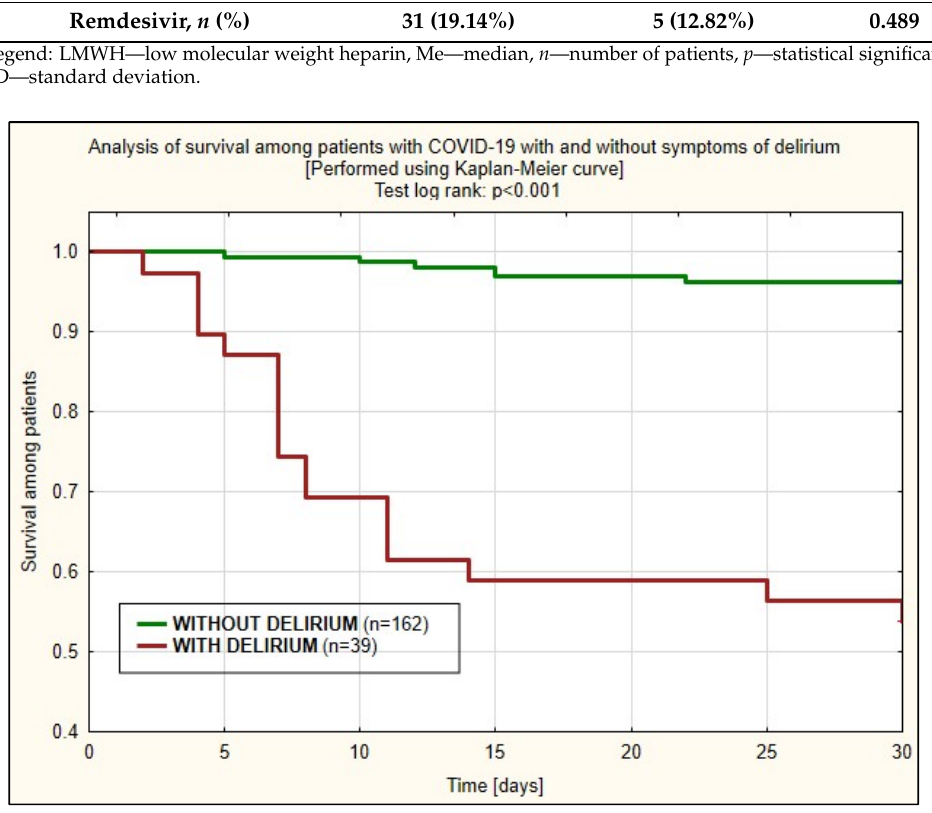
Figure 1. Analysis of survival among patients with COVID-19 with and without delirium.